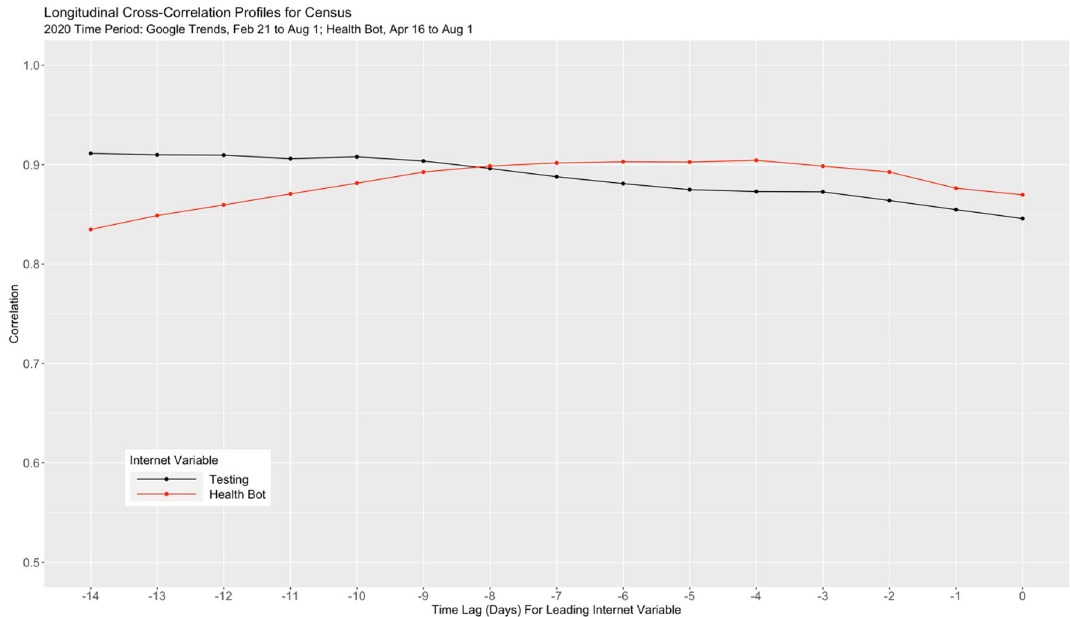
Figure 2. Longitudinal cross-correlation profiles for census and the two internet variables health bot and testing.